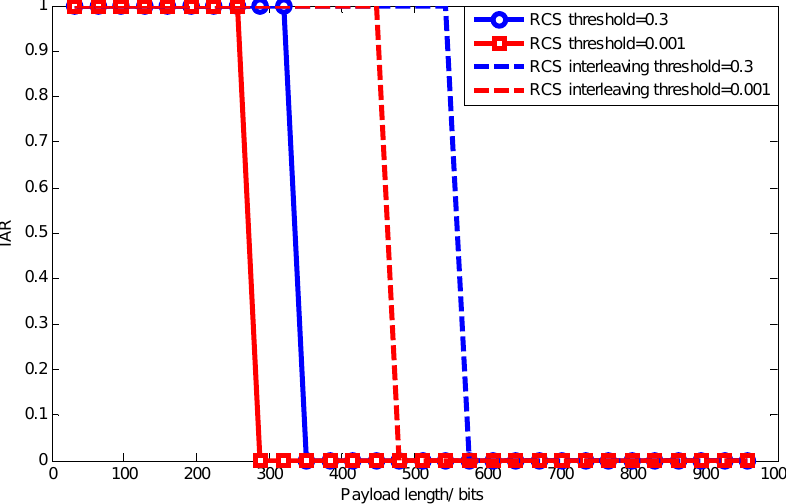
Figure 19. Signal transmission efficiency comparison after data interleaving.